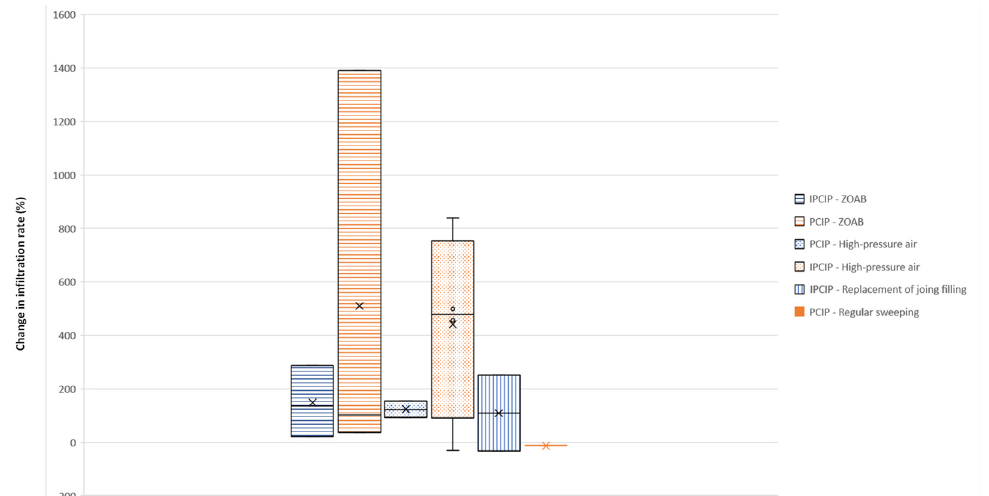
Figure 6. Boxplot showing the percentage change in infiltration capacity after maintenance, making a distinction in the effect of different maintenance techniques and IPCIP and PCIP systems. X visualizes the mean value.